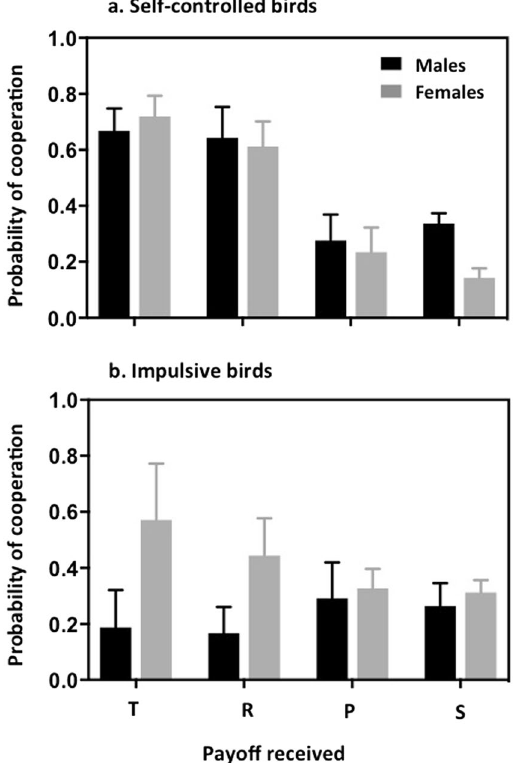
Figure 1. Mean ( ± SEM) probabilities of cooperation after the birds had received payoffs T, R, P and S, in self- controlled (panel a) and impulsive (panel b) birds. In both cases, the black and grey columns correspond to males and females, respectively.